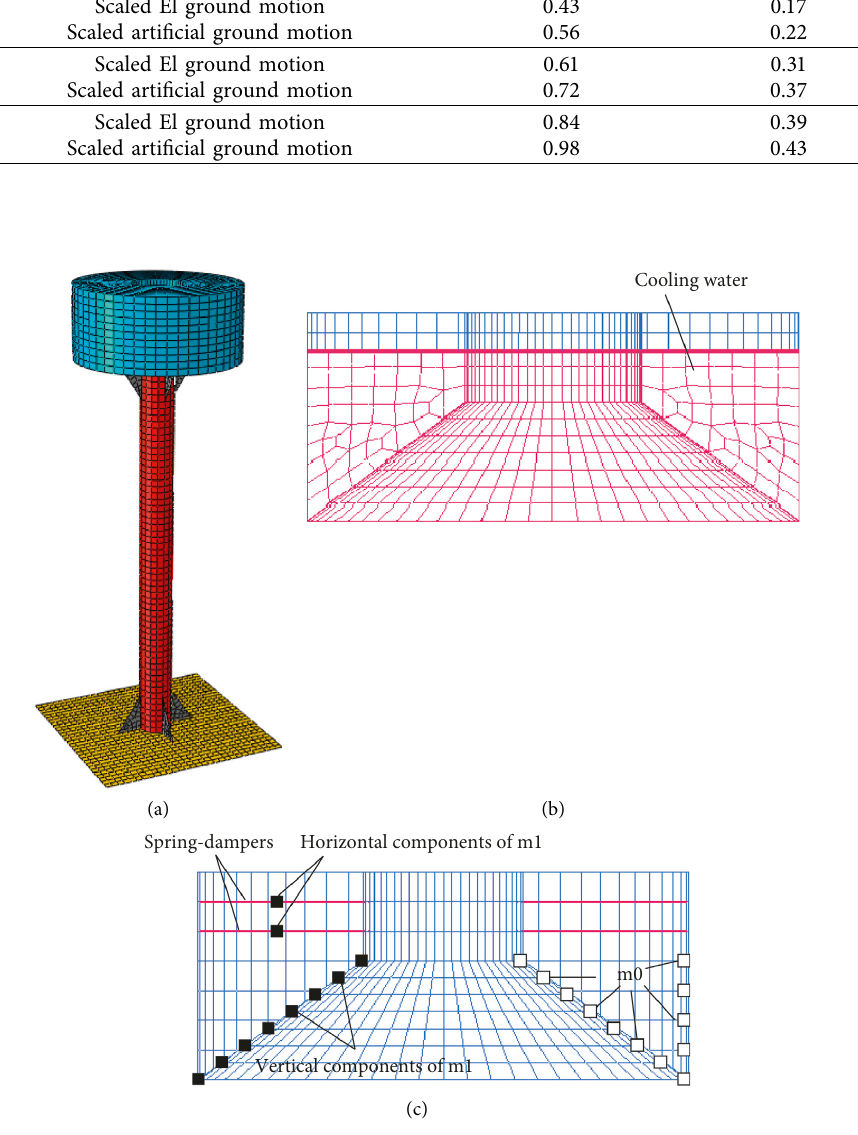
Figure 14: Numerical model of the test model. (a) Numerical model. (b) FSI model. (c) Simplified